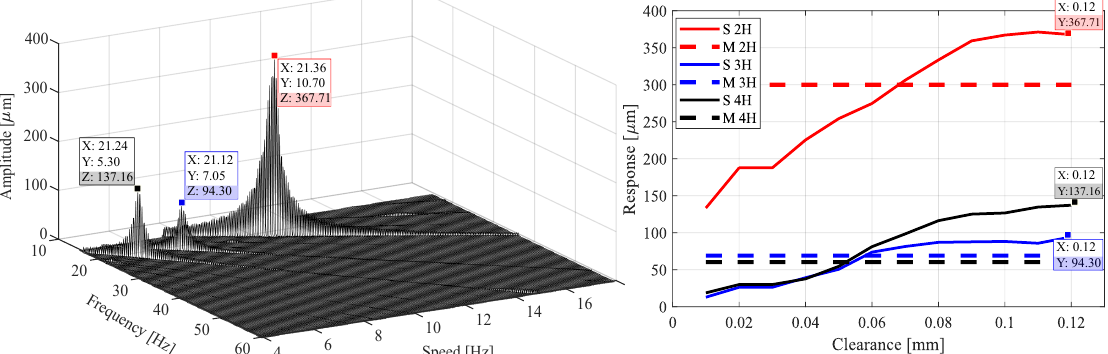
Figure 10. Peak responses for 2H, 3H, and 4H captured from the waterfall graphs. The peak responses were collected into a figure with all different bearing clearances. In this particular waterfall plot, the clearance was 120 µm.